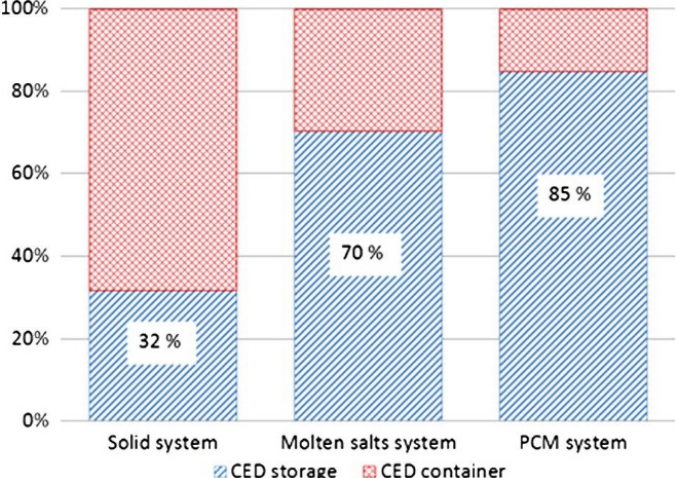
Figure 5. Influence of storage materials and container-embodied energy for the three systems [79]. (Reprint with permission [79]; 2019, Table 5. Summary of the CSP and TES life cycle assessment studies in CSP technologies. Reference